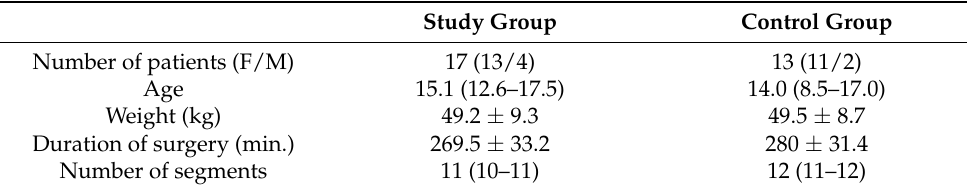
Table 1. Patients’